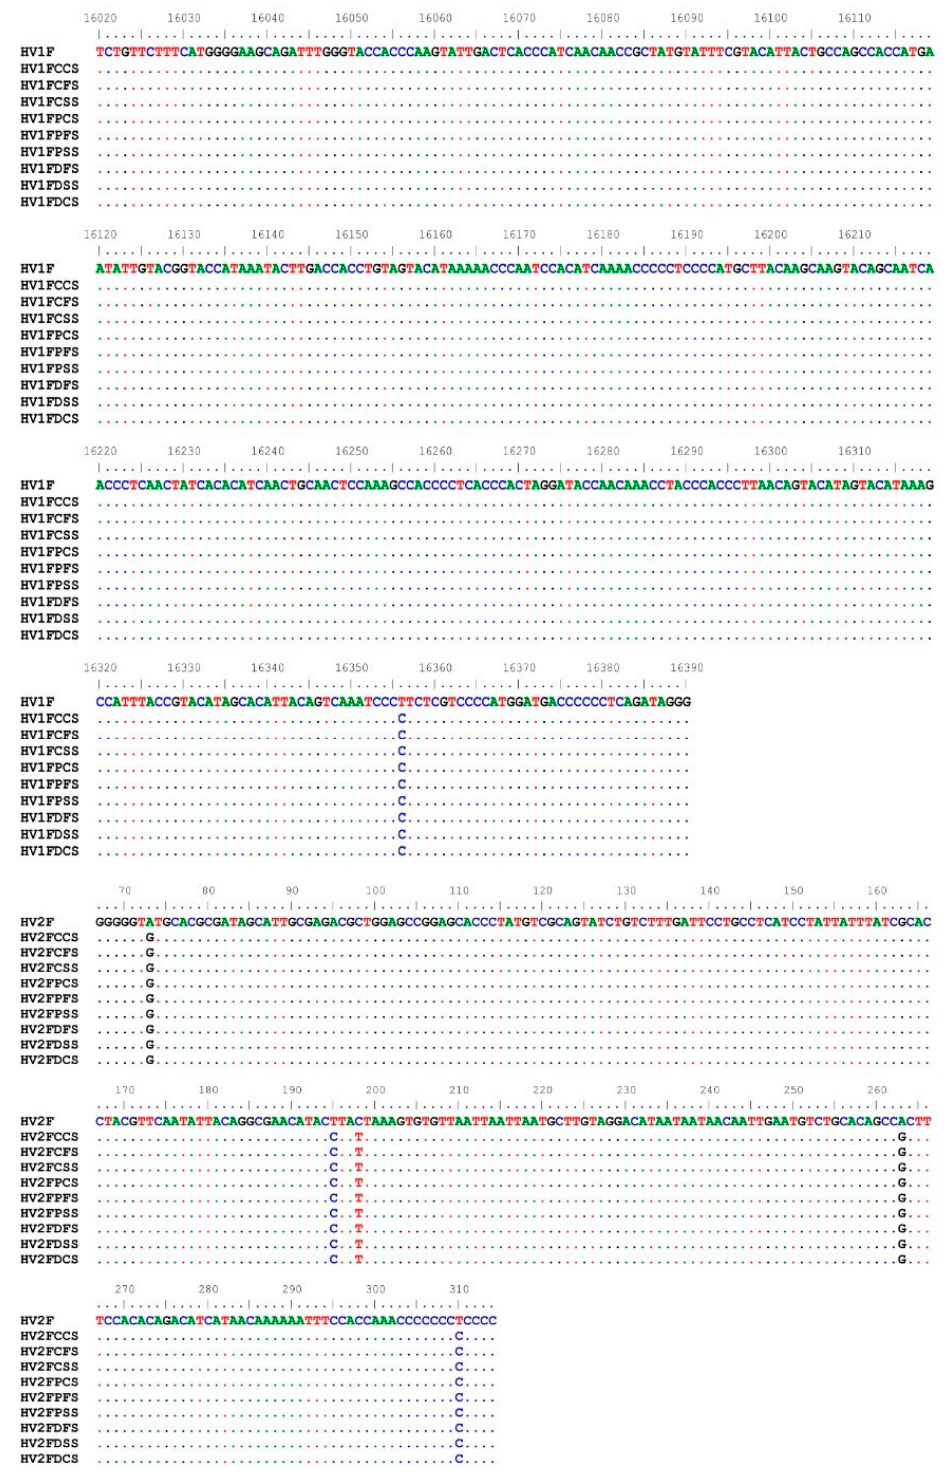
Figure 6. Representative HV1 and HV2 regions of mtDNA showing the mutations on the samples with respect to the revised Cambridge Reference sequence (in the top). CCS, Cotton Cotton swab; CFS, Cotton Flock swab; CSS, Cotton Subungal swab; PCS, Polyester Cotton swab; PFS, Polyester Flock swab; PSS, Polyester Subungal swab; DCS, Denim Cotton swab; DFS, Denim Flock swab; DSS, Denim Subungal swab. All samples analyzed yielded the donor’s haplogroup.